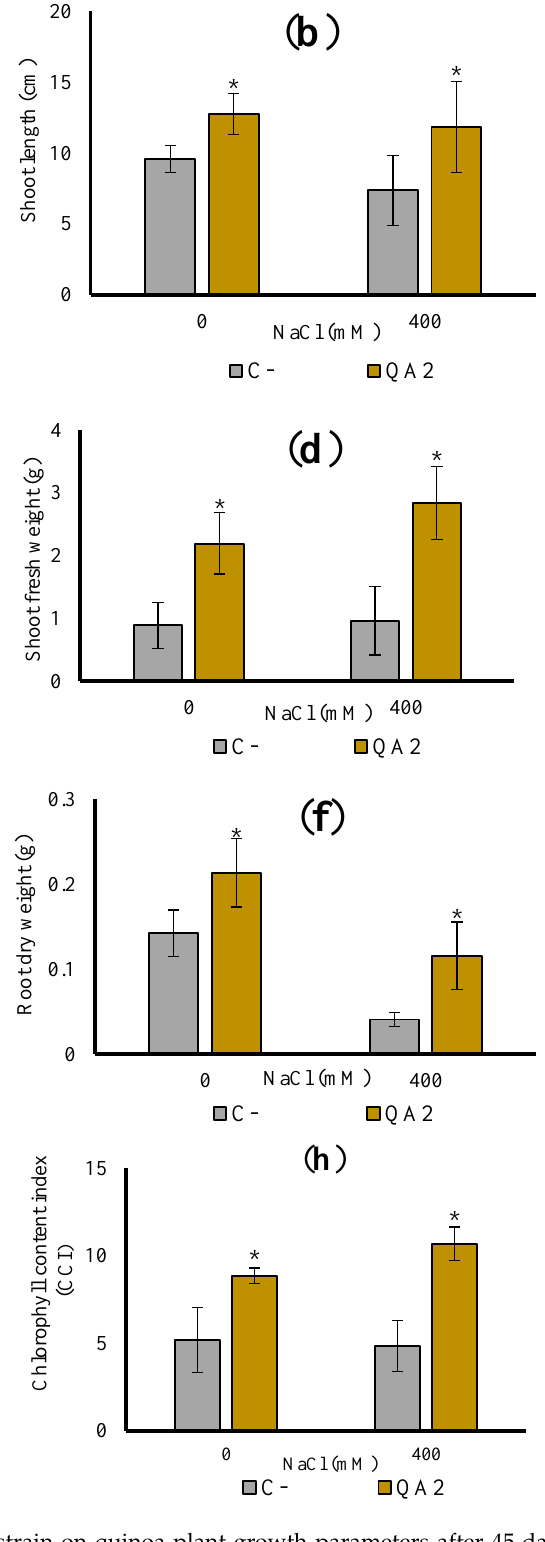
Figure 6. Effect of B. velezensis QA2 strain on quinoa plant growth parameters after 45 days of cultivation under saline conditions. ( a ) Root length, ( b ) Shoot length, ( c ) Root fresh weight, ( d ) Shoot fresh weight, ( e ) Leaf area, ( f ) Root dry weight, ( g ) Shoot dry weight, ( h ) chlorophyll content index. The values represent means of replicates (n = 4) ± standard deviations. Asterisks in superscript indicate the significant difference from the control at 95% between treatments.